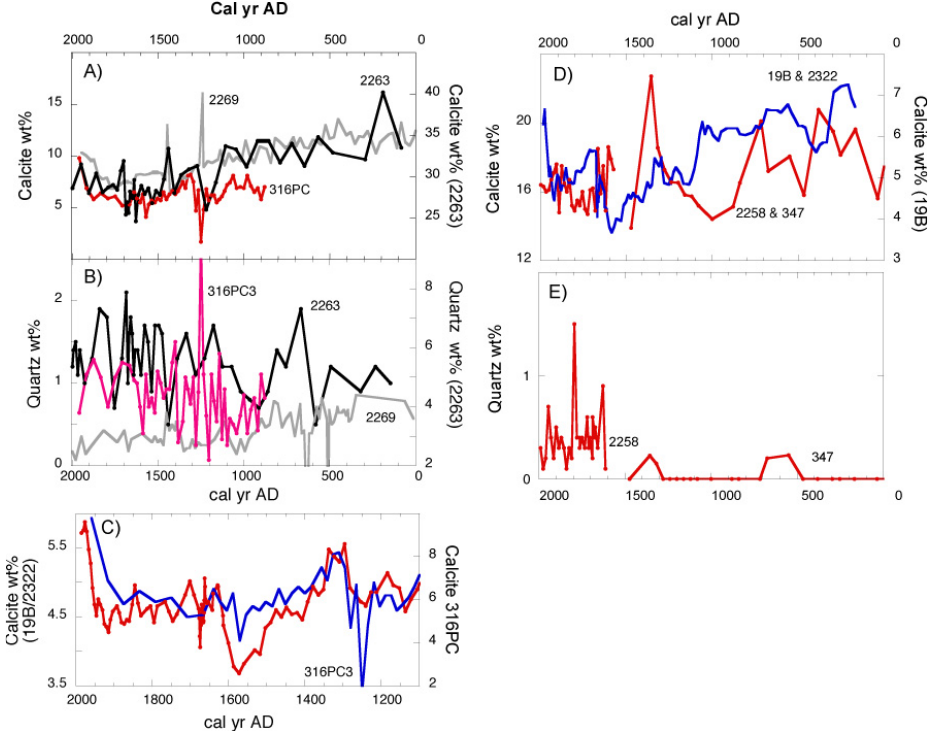
Fig. 9. (A) Calcite wt% data for sites MD99-2263 (left y axis), MD99-2269, and B997-316PC3 (right y axis) from N Iceland (Fig. 1). (B) Quartz wt% from same sites and same y axes. Note the difference in y axis values from the left to right axes. (C) Calcite wt% data from 316PC versus 19B/2322 over the last 1300yr. (D) Calcite wt% data for cores from SW Iceland (Fig. 1) compared to 2322. (E) Quartz wt% data from SW